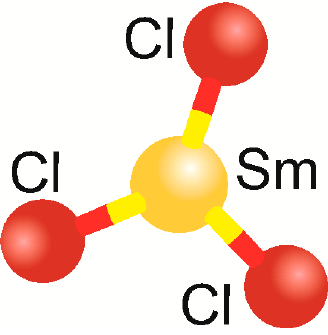
Figure 4. Structural formula of the SmCl 3 molecule.